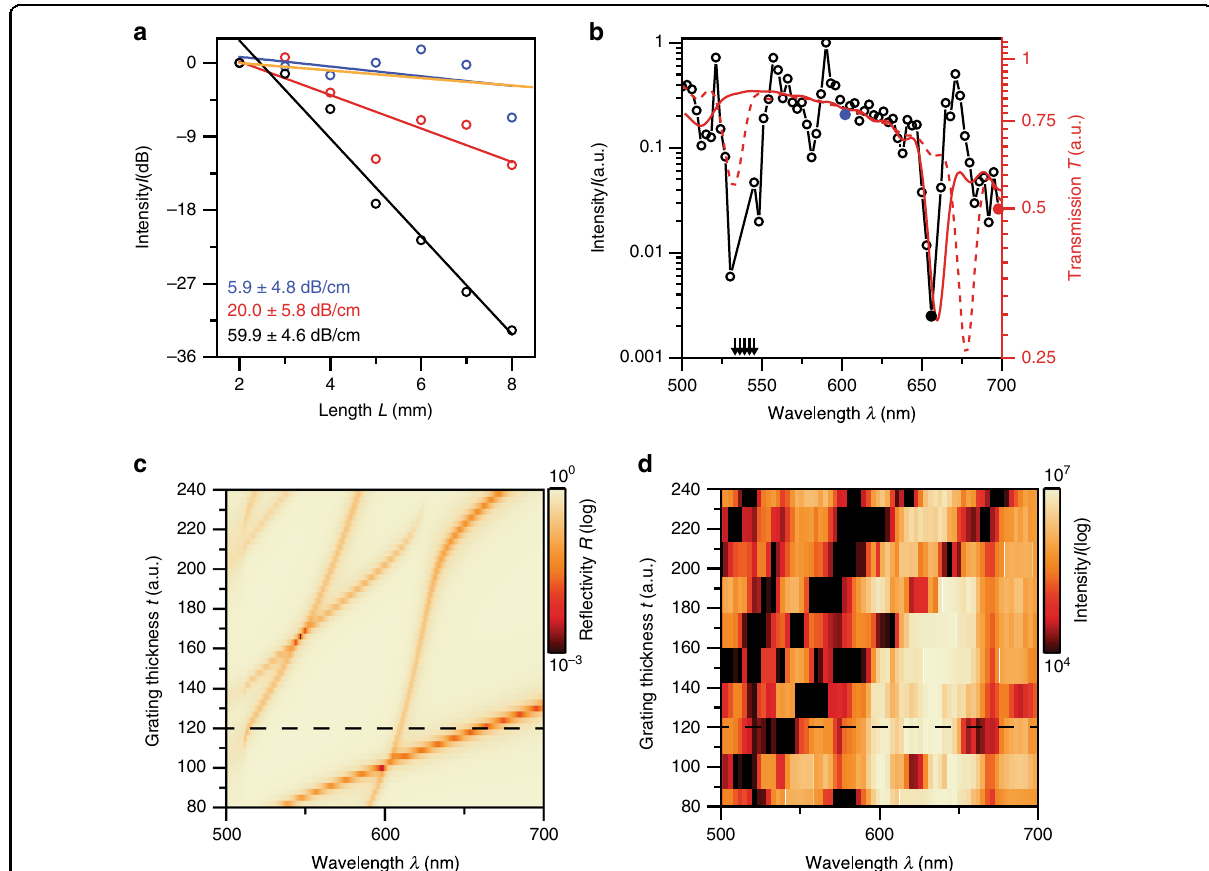
Fig. 4 Propagation loss and transmission spectrum. a Transmitted intensity as a function of waveguide length for different wavelengths, which are indicated in ( b ) by dots of the respective colour. Coloured circles are data points (each from a different waveguide device with the indicated length and t = 120 nm) measured for E z light polarization. Solid lines indicate linear fi ts to obtain the waveguide propagation loss. 3D FDTD simulations with excitation centred at approximately λ = 602 nm are shown as the orange line (see also Supplementary Fig. 5c). b Transmission spectrum through a 7-mm-long waveguide device with the experimental data shown as circles. Red dashed and solid lines are the 3D FDTD simulated spectra where gaps between HCG elements are fi lled with either air ( n air = 1) or SiON ( n SiON = 1.7), respectively. Coloured solid points show the wavelengths of the correspondingly coloured data in ( a ). Arrows indicate data points outside the displayed range. c Calculated re fl ectivity spectra of a single HCG obtained from RCWA for a θ = 85° incidence angle where the grating thickness t is varied. To achieve better agreement with the experiment, the full complex refractive index dispersion of Si is included, and the fi ll factor η = 65% and SiON refractive index n SiON = 1.9 are slightly altered within the fabrication uncertainty boundaries. d Measured transmission spectra of 7-mm-long HCG waveguides with t = 80 – 240 nm (10 different geometries). Dashed black lines in ( c , d ) indicate the waveguide geometry from which the experimental data in ( a , b ) are